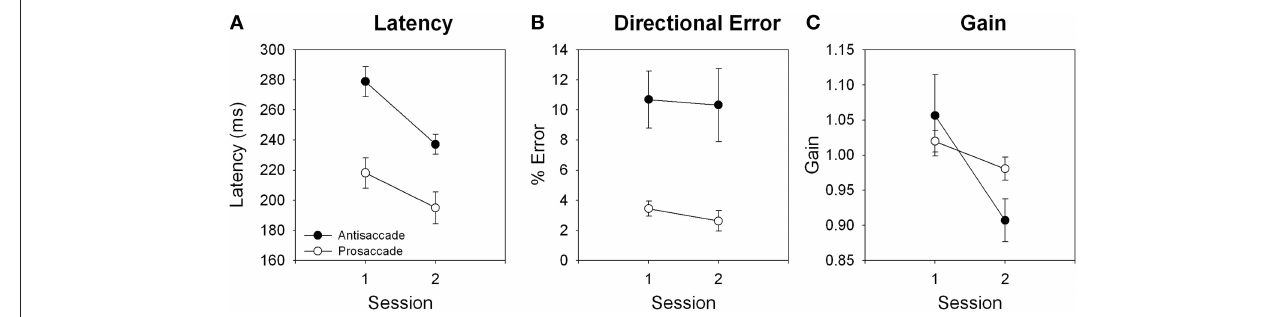
of training on an antisaccade task optimized to induce learning effects, antisaccade latency and gain decreased relative to pre- training levels. Training was associated with increased activity